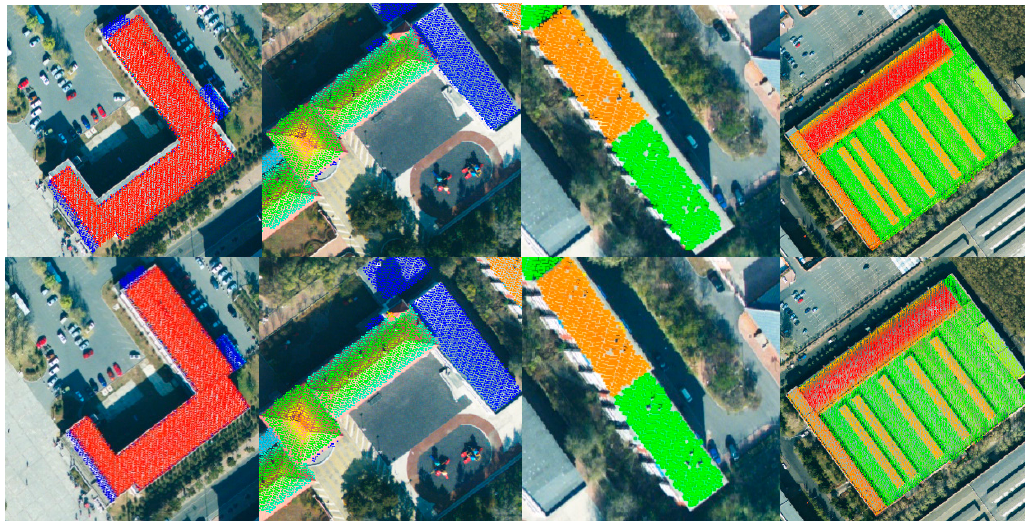
Figure 9. Visual comparison showing the coarse registration results, on the top row, and the precise registration results, on the bottom row.